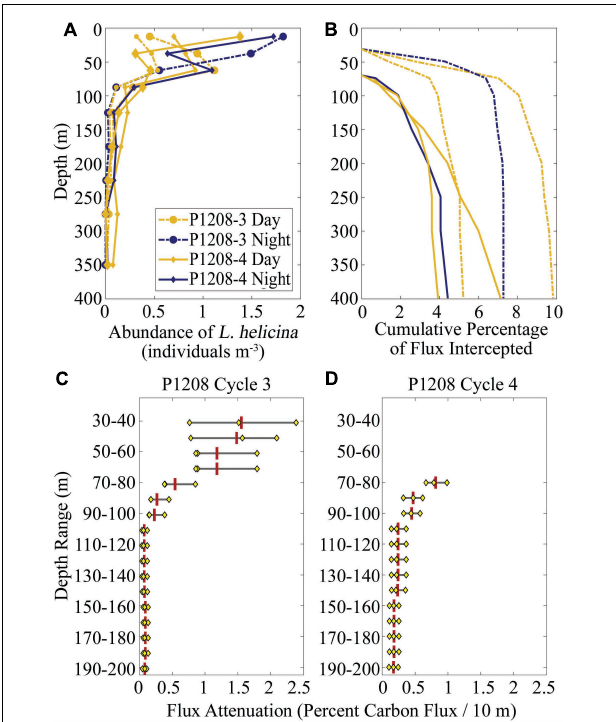
FIGURE 9 | Importance of pteropods to flux attenuation. The abundance of Limacina helicina in MOCNESS tows conducted during two cycles on the P1208 cruise from Bednaršek and Ohman (2015) (A) . The cumulative percentage of flux intercepted by L. helicina based on abundances measured during each MOCNESS tow and assuming a 45-mm diameter for the mucous feeding web (B) . Cumulative percentage flux is calculated starting at the base of the euphotic zone (1% light level), which was at 30 m on P1208-3 and 70 m on P1208-4. Panels (C) and (D) show computed flux attenuation mediated by Aulosphaeridae. Black line shows the range of values measured on the three tows for each Cycle (which are depicted as yellow diamonds). Vertical red line is arithmetic